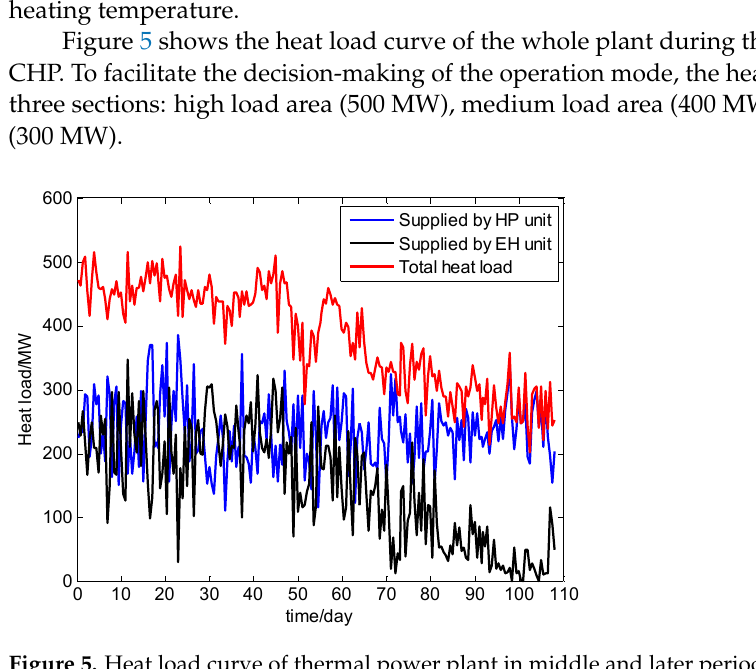
Figure 5. Heat load curve of thermal power plant in middle and later period. According to each heat load, the simulation calculation for four unit-commitment modes under different power loads of the whole plant is carried out. The optimization model of the plant-level economic load in Section 4.3 is adopted for calculation, and the optimization period is 15 min. Under the optimal load allocation, coal consumptions (15 min) in different unit commitment modes are shown in Figure 6.